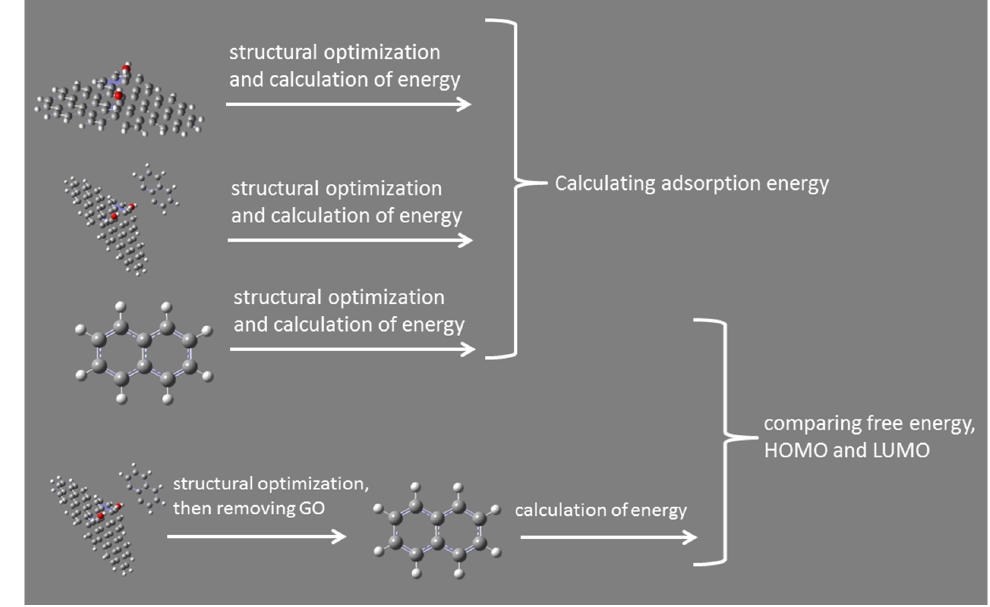
Figure 2. The flow chart of calculation in this study.